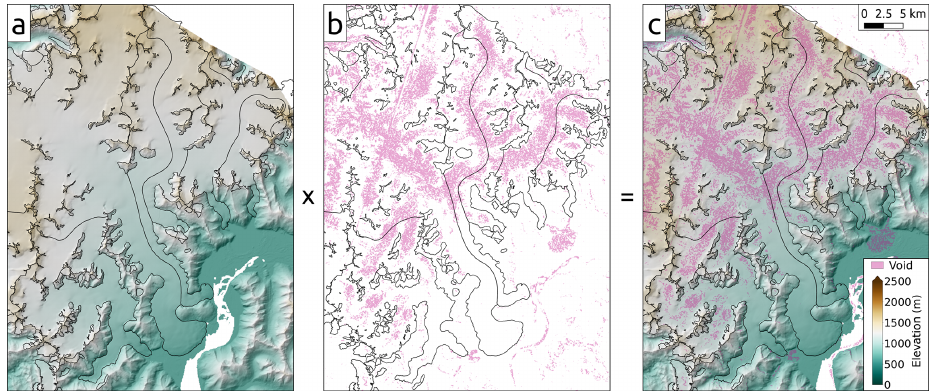
Figure 2. Example of masking procedure over Taku Glacier, with RGI outlines shown in black. The IfSAR DEM (a) is masked using the composite correlation mask from the ASTER products with a correlation threshold (here 50%) (b) to produce a DEM (c) with voids (in purple) similar to expected voids in an optical DEM. In panel (b) , purple represents areas where the ASTER correlation is below the chosen